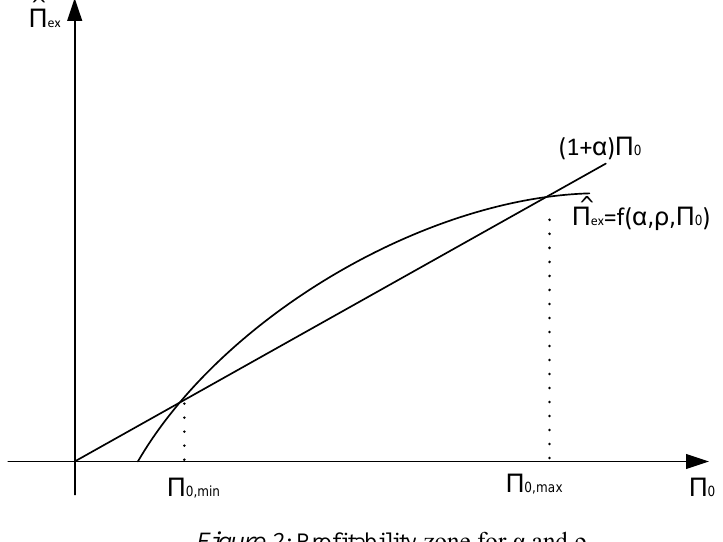
Figure 2 : Profitability zone for α and